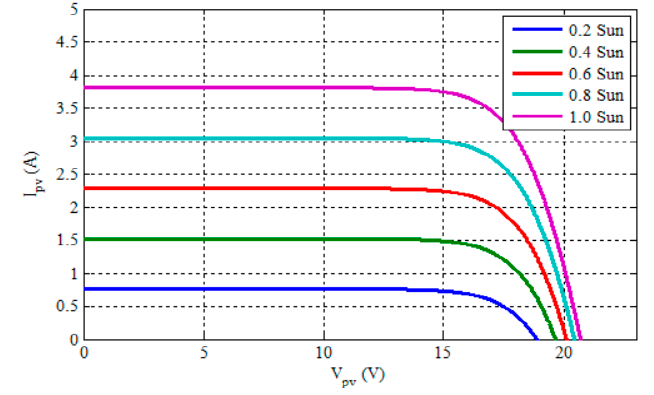
Figure 22. I vs. V Characteristics with varying irradiance.